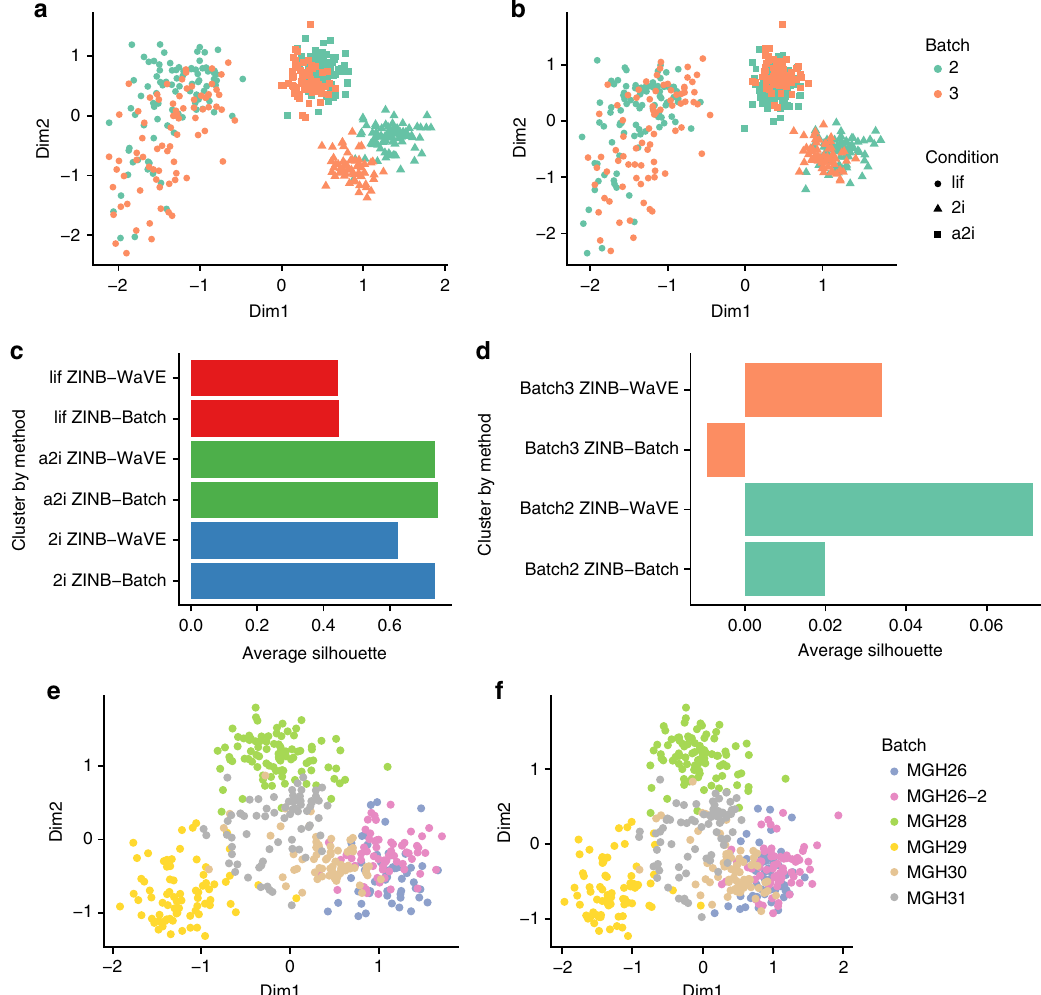
Fig. 5 Accounting for batch effects in ZINB-WaVE. Upper panels provide two-dimensional representations of the mESC data, with cells color-coded by batch and shape re fl ecting culture conditions: a Default ZINB- WaVE with only sample-level intercept; b ZINB-WaVE with batch as known sample-level covariate. c Average silhouette widths by biological condition for ZINB-WaVE with and without batch covariate; d average silhouette widths by batch for ZINB-WaVE with and without batch covariate. Although the cells cluster primarily based on culture condition, batch effects are evident in a . Accounting for batch effects in the ZINB-WaVE model ( b ) leads to slightly better clustering by biological condition ( c ) and removes the clustering by batch ( d ). Note the difference in scale between the barplots of c and d . Lower panels provide two-dimensional representations of the glioblastoma data, with cells color-coded by batch: e Default ZINB-WaVE with only sample-level intercept; f ZINB-WaVE with total number of expressed genes as sample-level covariate.